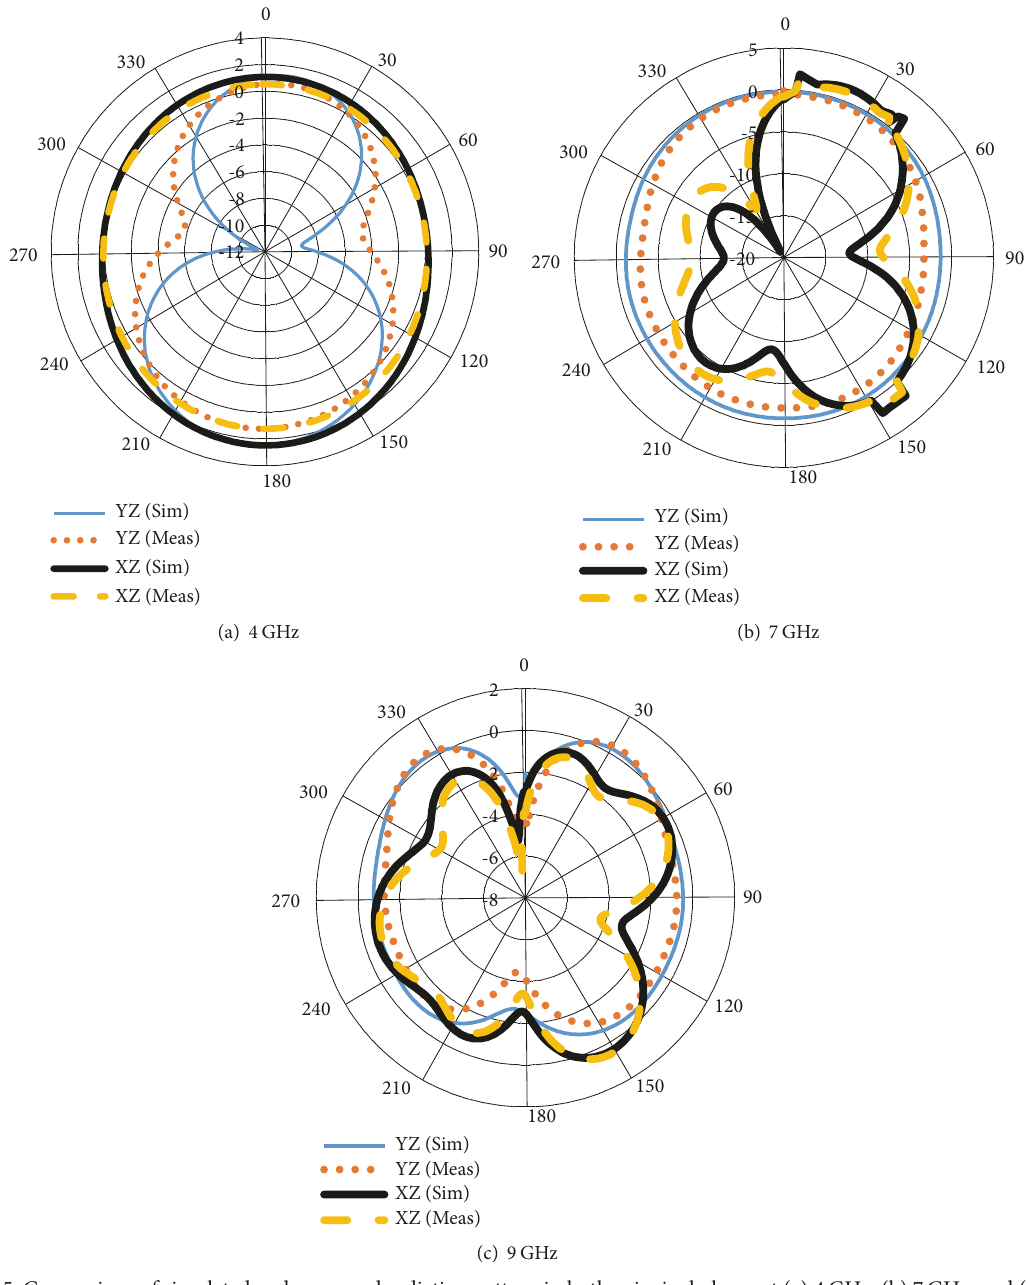
Figure 15: Comparison of simulated and measured radiation pattern in both principal planes at (a) 4GHz, (b) 7 GHz, and (c) 9 GHz.